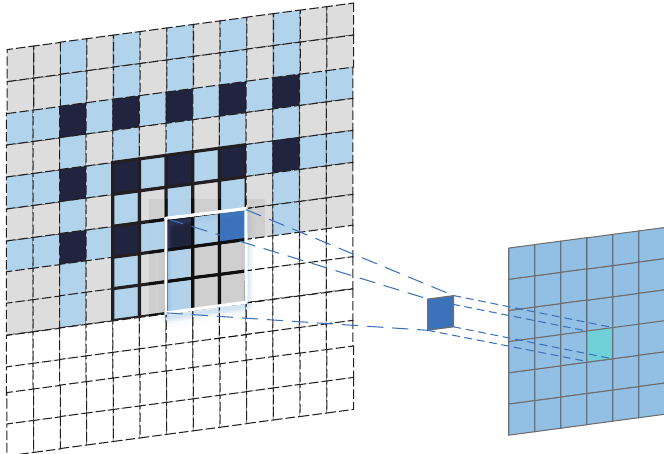
Figure 5. An example of a checkerboard artifacts. Checkerboard artifacts occurs when a 3 × 3 convolution deconvolution on a 5 × 5 feature map with stride =